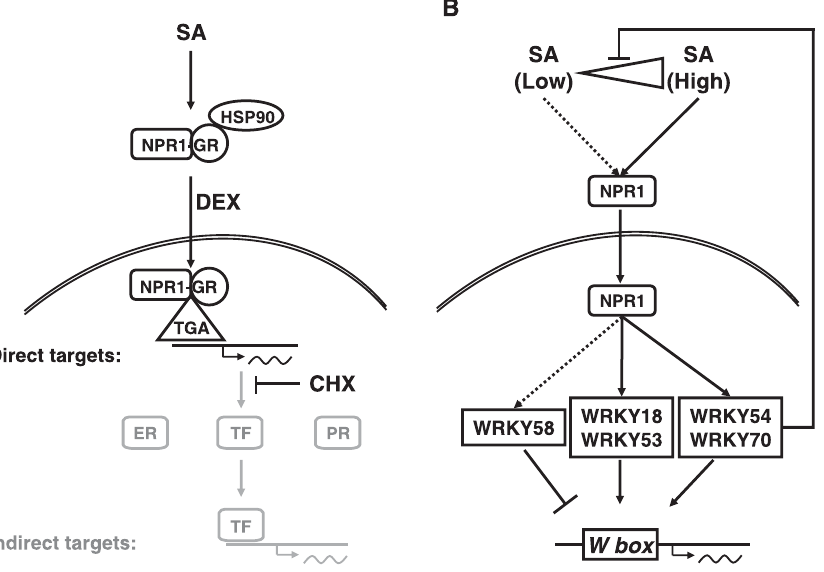
Figure 1. Differential Regulation of SAR by NPR1-Induced WRKY Factors (A) A schematic representation of the strategy to identify NPR1 direct targets. SA treatment activates components of the SAR pathway upstream or independent of NPR1. Subsequent application of dexamethasone (DEX) triggers nuclear translocation of the NPR1-GR fusion protein to activate existing TGA transcription factors. Direct target genes of NPR1 are transcribed but not translated in the presence of the inhibitor cycloheximide ( CHX) to prevent transcription of indirect target genes. ER, endoplasmic reticulum–resident proteins; TF, transcription factors; PR, pathogenesis-related proteins. (B) Mode of action for the NPR1-target WRKY factors. In WT, SA accumulation triggers nuclear localization of NPR1, which directly induces several WRKY genes. When SA levels are low, WRKY58 functions to prevent (blocked arrow) spurious activation of SAR (dotted lines). When SA levels are high, signaling through positive WRKY factors overcomes the negative effect of WRKY58 to activate (arrow) downstream gene transcription (solid lines). In addition, WRKY70 and WRKY54 prevent excessive SA accumulation (blocked